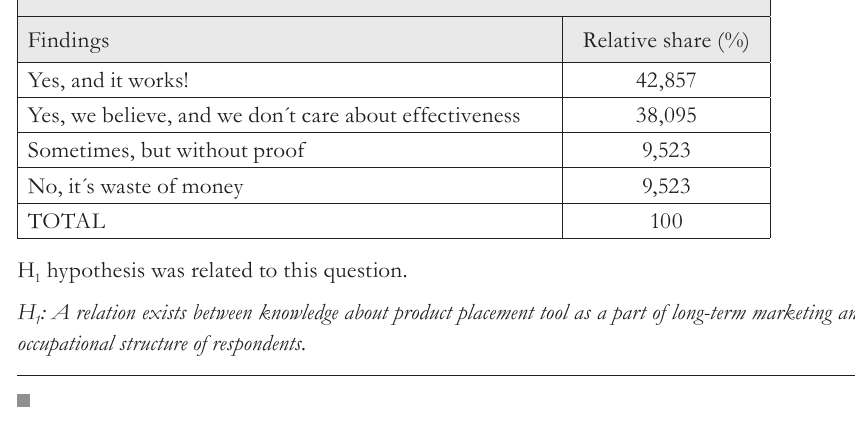
Tab. 2 – Knowledge about product placement tool as a part of long-term marketing.